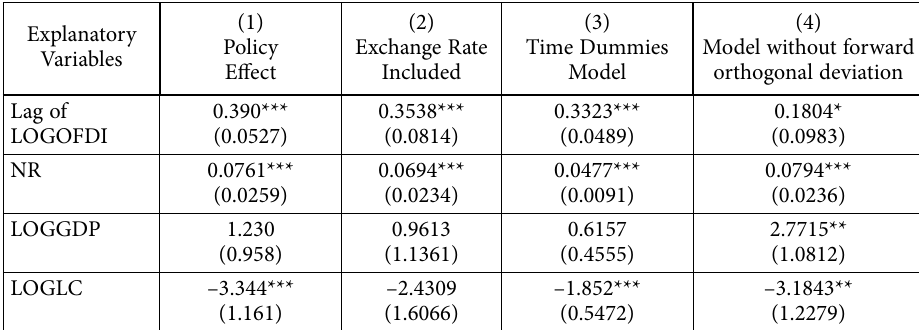
Table 4. The determinants of China Outward Direct Investment (COFDI) using Augmented Dunning Model (whole sample) Explanatory